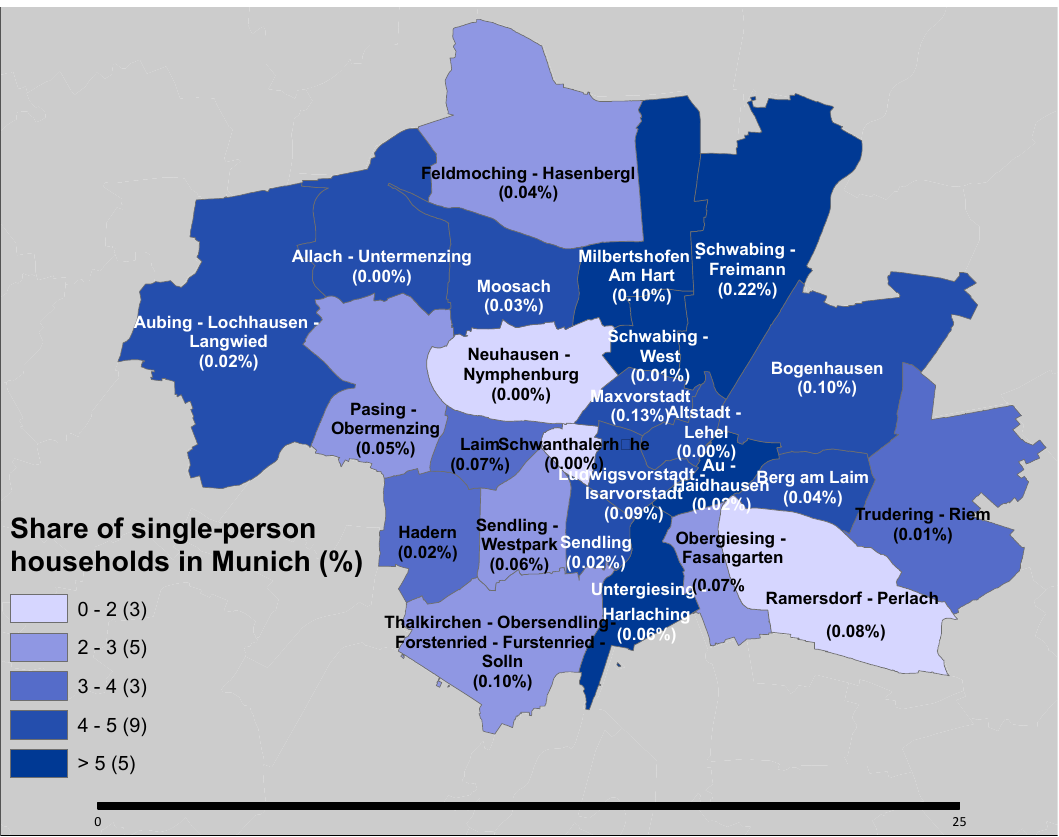
Figure 6. Share of single-person households across Munich boroughs and difference in absolute value between control totals and the results after the